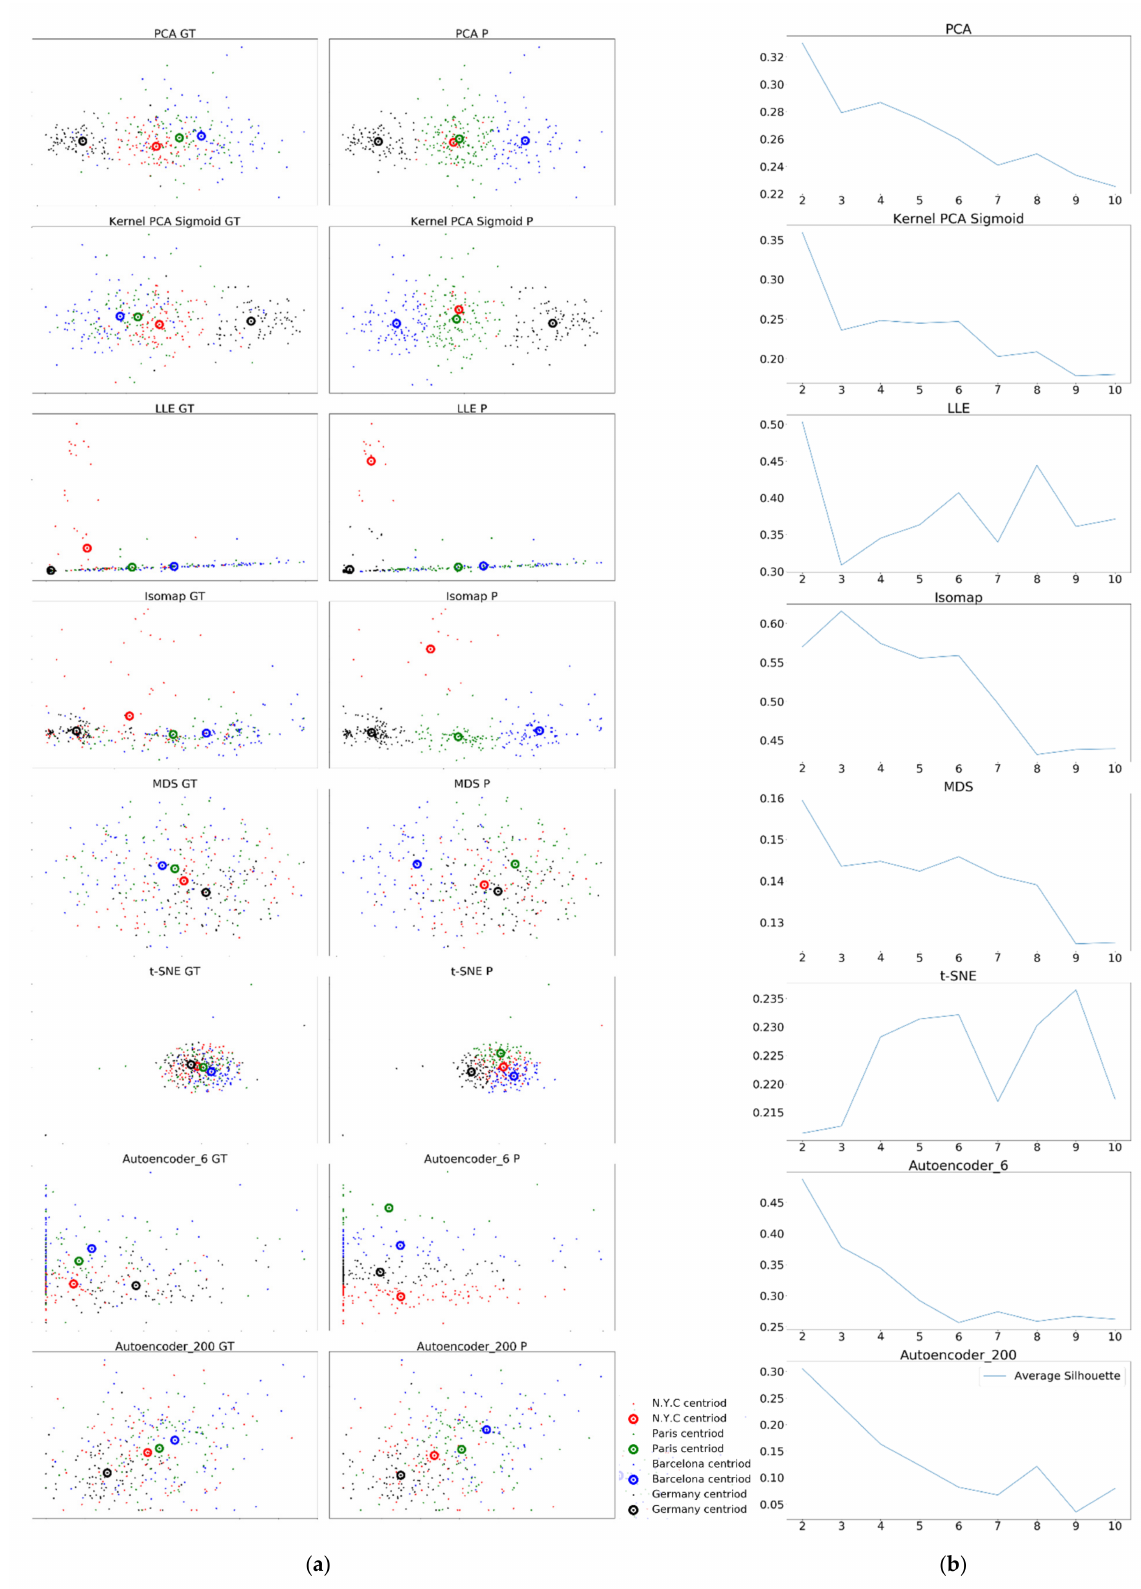
Figure 14. Clustering performance. In ( a ), each colored dot represents a data sample projected using the corresponding method. Ground-truth data are labeled with GT and prediction P. Each unique color indicates distinct clusters. Subfigure ( b ) demonstrates plots of Silhouette Coefficient value for each method when changing the number of clusters, which is depicted on the